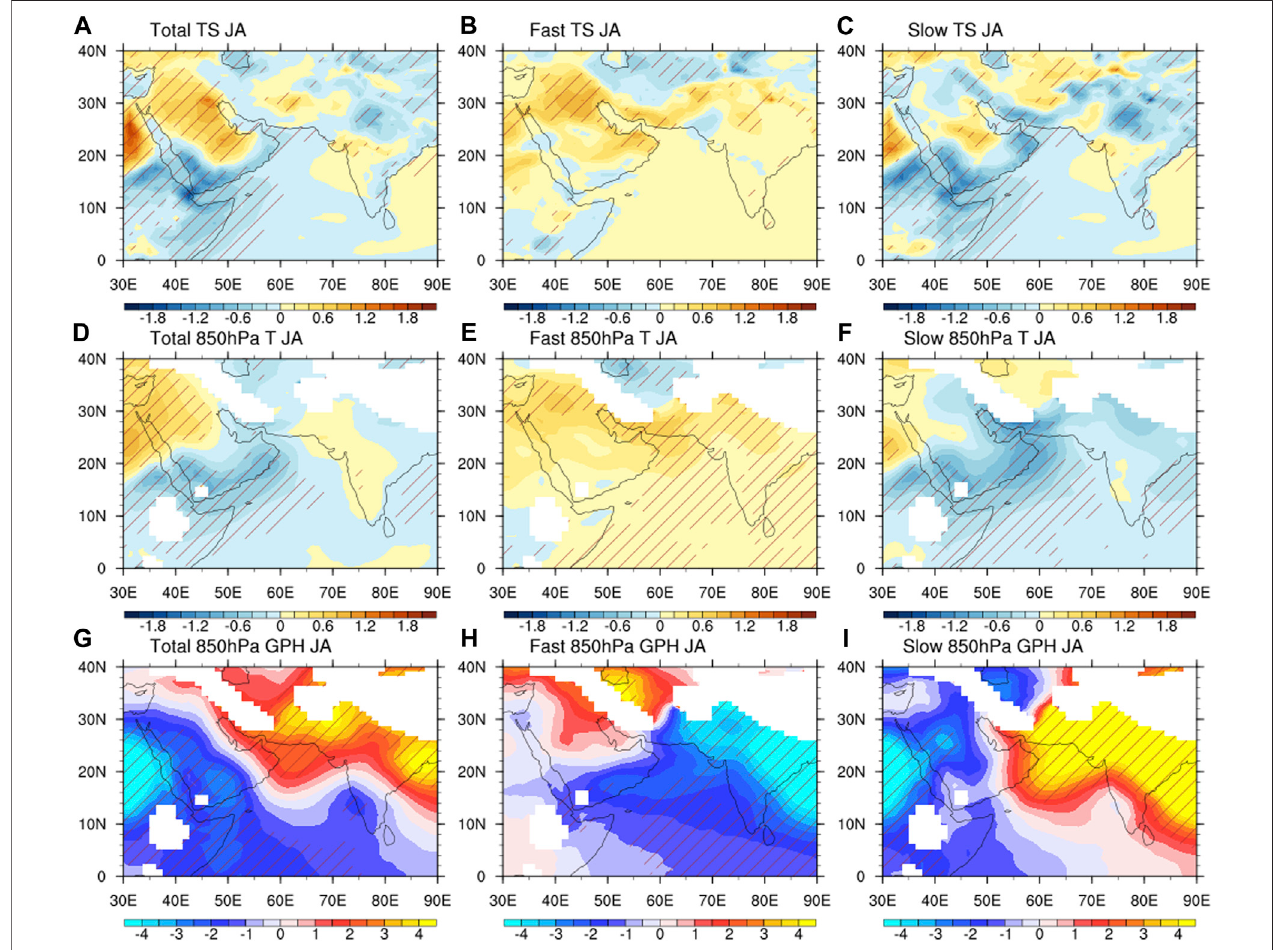
FIGURE 12 | The total [ (A,D,G) , CMD − CMN], fast [ (B,E,H) , UMD − UMN] and slow [ (C,F,I) (CMD − CMN) − (UMD − UMN)] responses of temperature at the surface (A – C,K) and 850 hPa (D – F,K) as well as those of geopotential height [ (G – I) , gpm] at 850 hPa to the dust DRE during the late monsoon season (July – August). Brown lines represent the values statistically signi fi cant at the 0.1